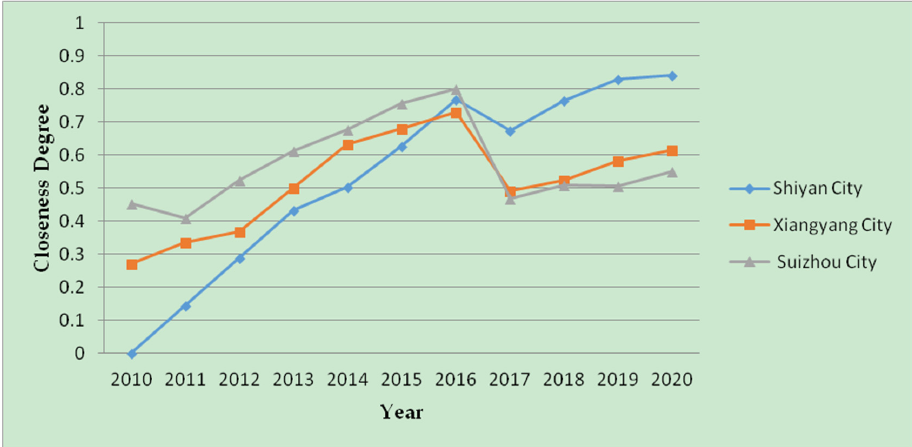
Figure 4. The closeness degree of the social benefits of cultivated land use in three study areas dur- ing 2010–2020.